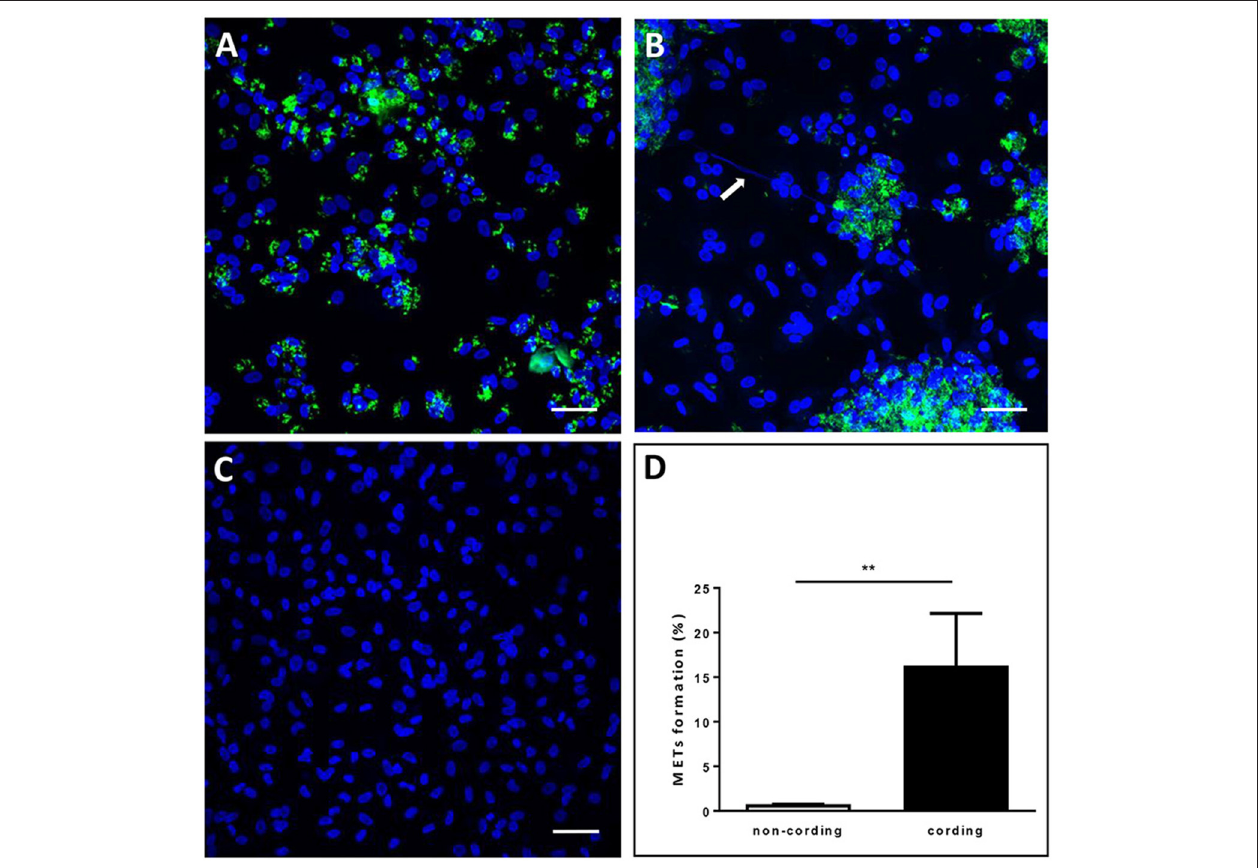
FIGURE 2 | Cording M. tuberculosis induces MET formation in human macrophages. hMDMs were infected with GFP-expressing H37Rv (green) (A) non-cording or (B) cording at MOI 10 or (C) left uninfected. The cells were then incubated for 24 h, fixed and stained with DAPI (blue). The white arrow indicates METs release by human macrophages. Bar: 20 µ m. (D) The percentage of MET-forming macrophages was quantified after 24 h of H37Rv infection. Mean values ± SEM from 8 images are shown ( n = 3). ** p <